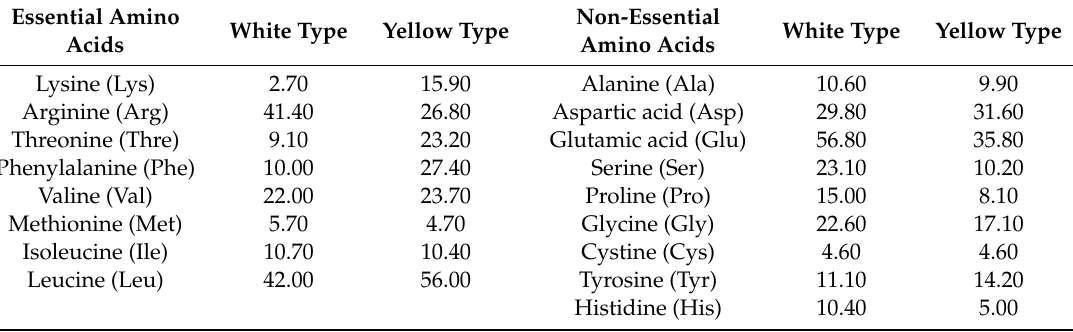
Table 2. Amino acid composition of ginger